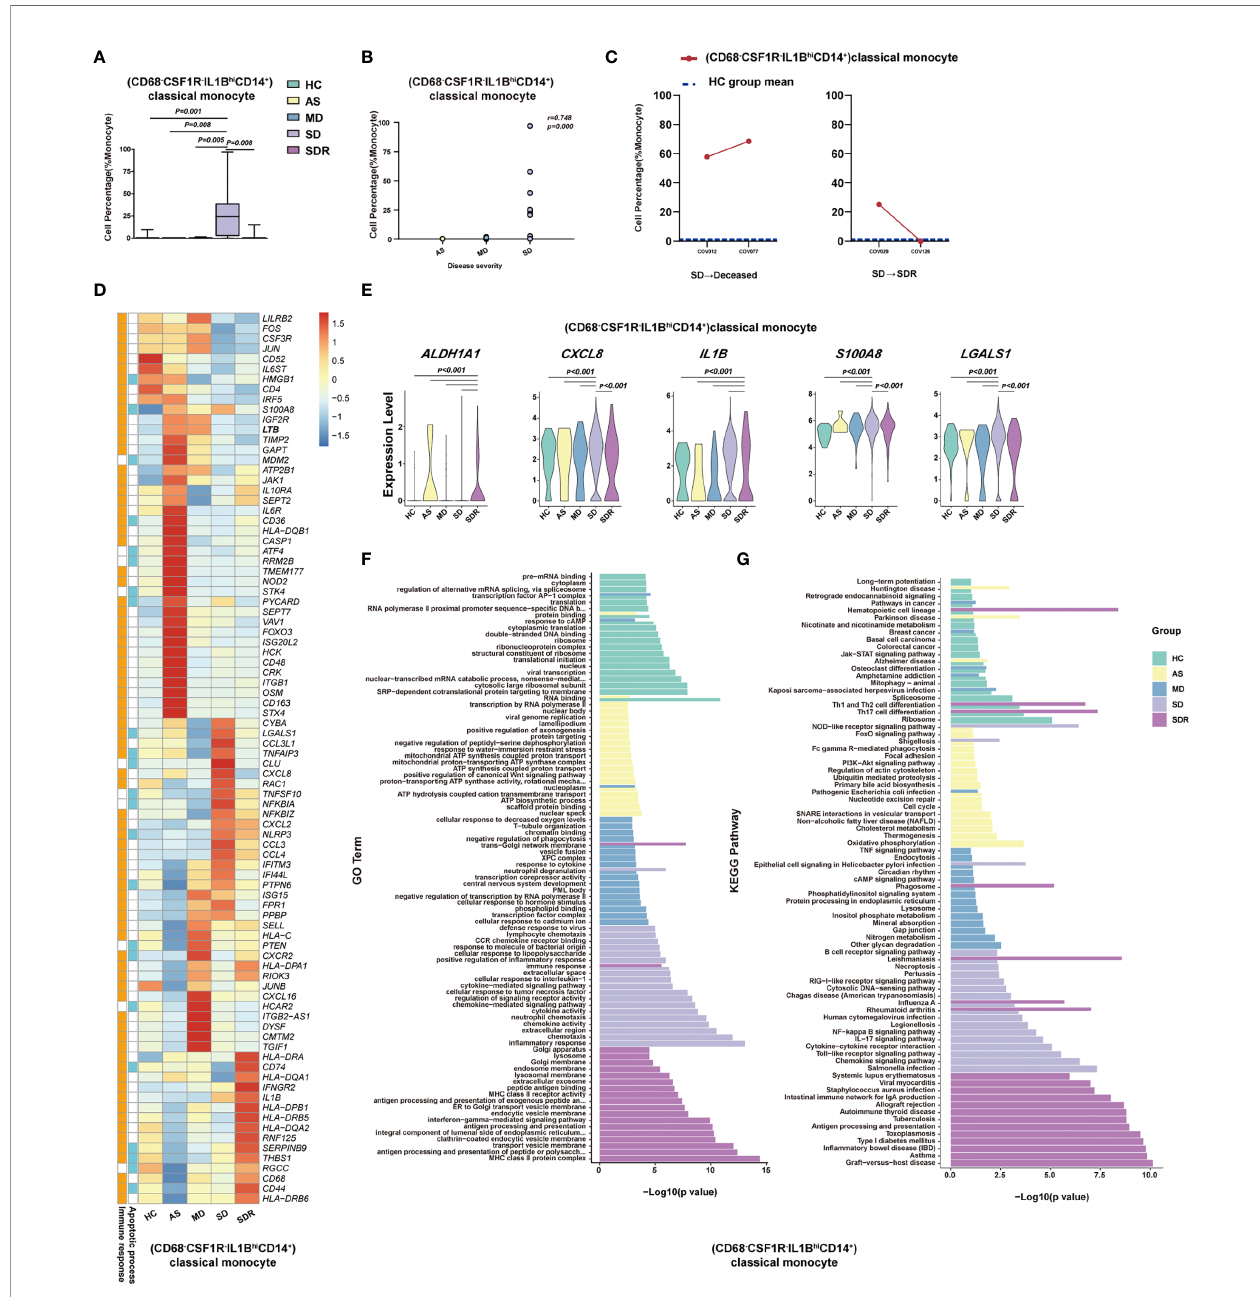
FIGURE 5 | (CD68-CSF1R-IL1BhiCD14+)classical monocyte correlated with disease severity of COVID-19 patients. (A) The Box and whisker plots showing the percentage of (CD68 - CSF1R - IL1B hi CD14 + )classical monocytes that showed signi fi cant differences (p<0.05) between the HC, AS, MD, SD and/or SDR groups. The horizontal lines, box and whiskers correspond to median value, interquartile range (IQR) and minimum/maximum value, respectively. (B) Spearman rank order correlation analysis showing the signi fi cant associations between (CD68 - CSF1R - IL1B hi CD14 + )classical monocytes with the disease severity. (C) The alternation trend of (CD68 - CSF1R - IL1B hi CD14 + )classical monocytes in the fatal patient (COV012/COV077) and one recovery SD patient (COV029/COV126). (D) The Heatmap showing the average level of the DEGs in the (CD68 - CSF1R - IL1B hi CD14 + )classical monocytes with p<0.05 and log2 fold change (FC) ≥ 0.26 in HC, AS, MD, SD, and SDR. The gene function (immune responses and apoptosis) is indicated in the heatmap. The gene expression was calculated via LogNormalize method of the “ NormalizeData ” function of the Seurat software. (E) The violin plots showing the expression levels of fi ve representative DEGs ( ALADH1A1, CXCL8, IL1B, S100A8 , and LGALS1 ) in (CD68 - CSF1R - IL1B hi CD14 + )classical monocytes, which were involved in apoptosis and/or immune responses. (F) Gene Ontology (GO) analysis. Top 20 signi fi cant GO terms sorted by − log10 (p) value from HC, AS, MD, SD, and SDR were shown, respectively. (G) KEGG pathway analysis. Top 20 signi fi cant KEGG pathways sorted by − log10 (p value) from HC, AS, MD, SD, and SDR were shown, respectively (also see Figure S4 ). p<0.05 was considered signi fi cant. The samples included HC (n=11), AS (n=5), MD (n=13), SD (n=11, one patient was sampled twice at different disease stages) and SDR (n=11, one sample was sampled at different disease